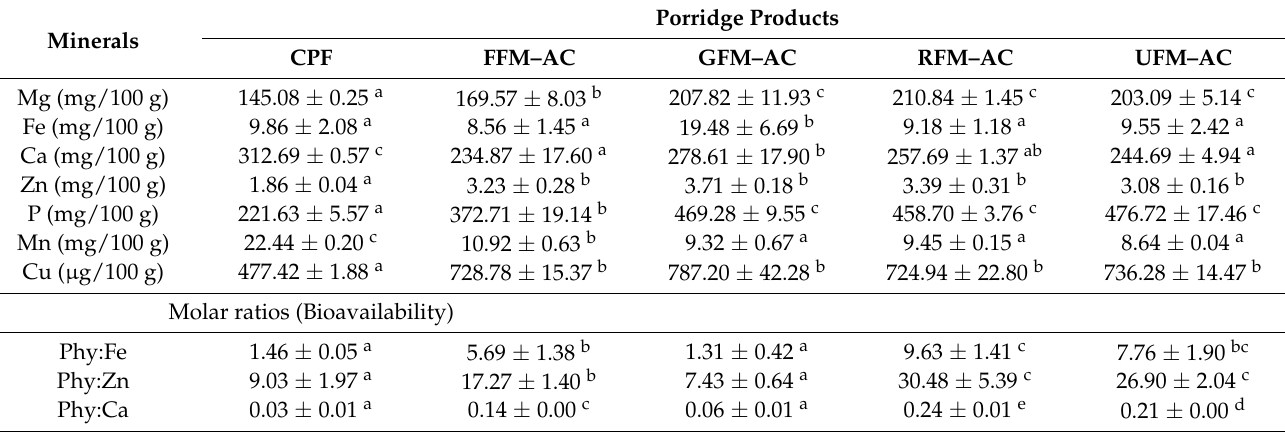
Table 4. Mineral content and bioavailability of porridge flour